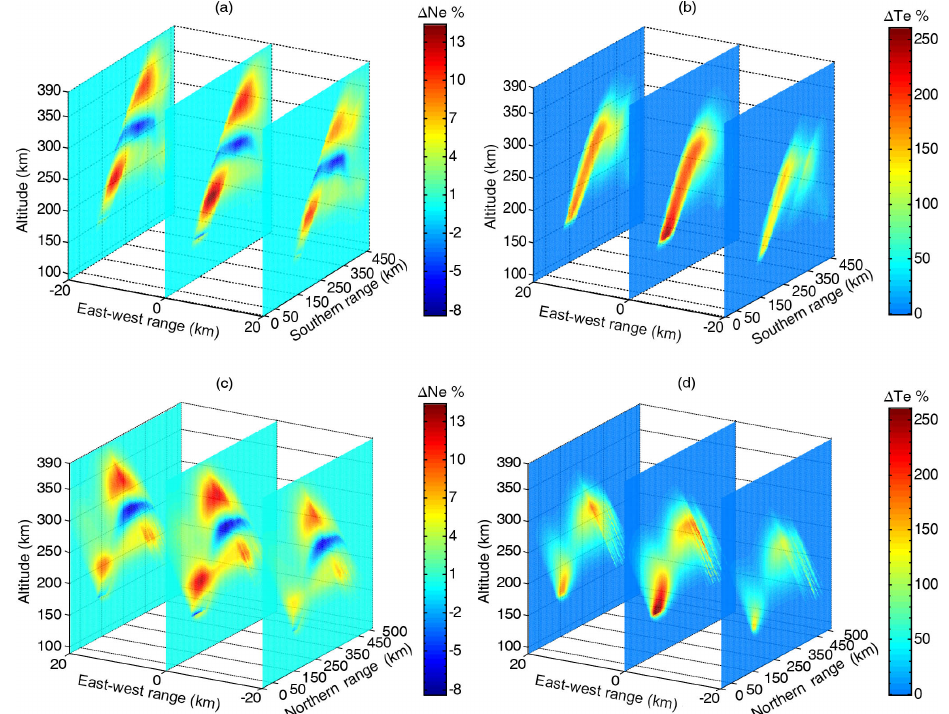
Figure 3. The ionospheric electron density and temperature change due to oblique ionospheric heating. (a) The electron density change in three slices with the heating wave incidence parallel to the magnetic field line. (b) The electron temperature change in three slices with the heating wave incidence parallel to the magnetic field line. (c) The electron density change in three slices with the heating wave incidence perpendicular to the magnetic field line. (d) The ionospheric electron temperature change presented in three slices with the heating wave incidence perpendicular to the magnetic field